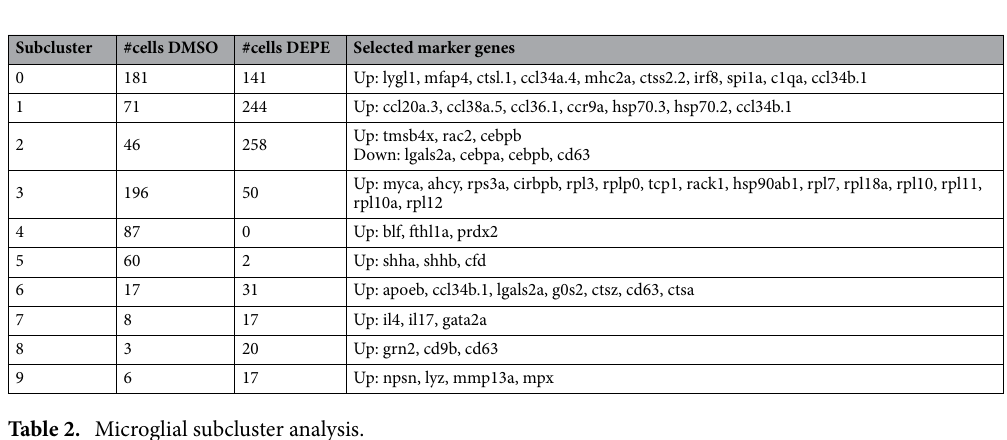
Table 2. Microglial subcluster